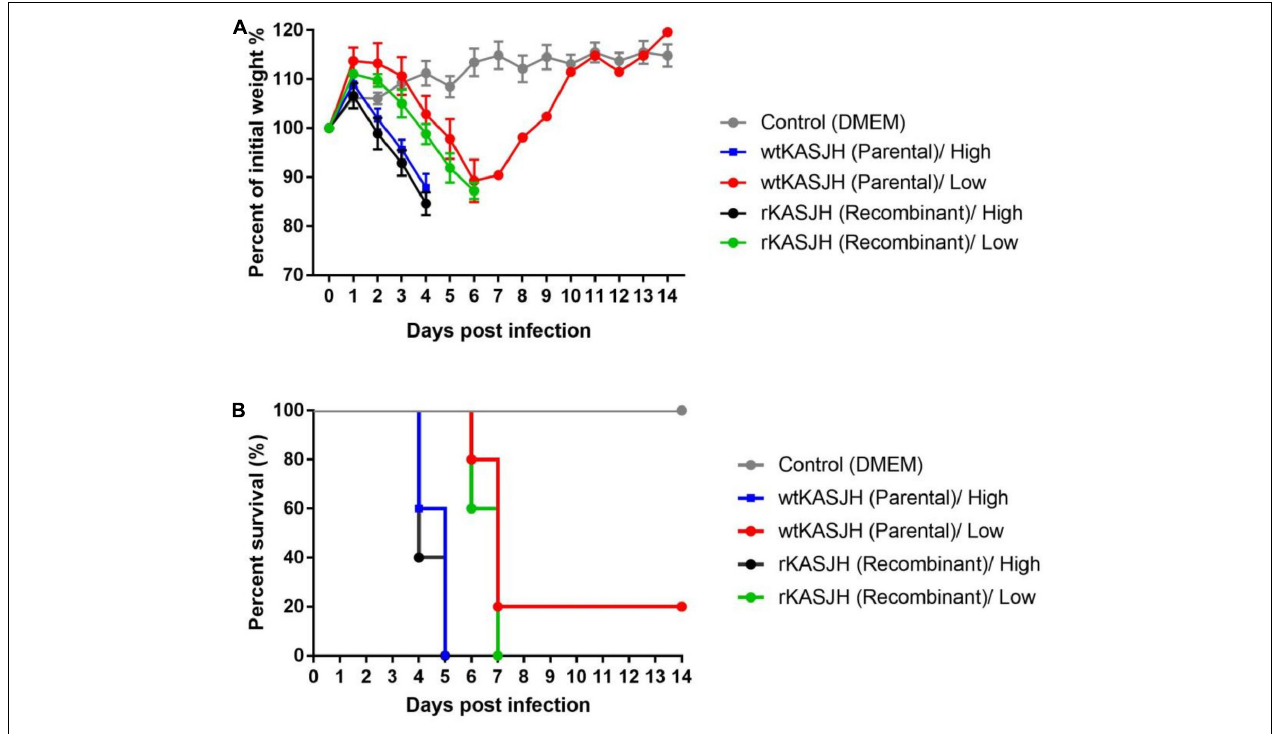
FIGURE 3 | Virulence of parental and rescued SFTSVs in C57BL/6 IFNAR − / − mice. Groups of five mice were inoculated intramuscularly with high (1 × 10 5 FFU) and low (1 × 10 2 FFU) doses of the indicated viruses and then monitored for weight loss (A) and mortality rate (B) . Error bars indicate standard deviations of the mean. Survival was quantified using the Kaplan-Meier method and tested for significance by log-rank analysis. ns, not